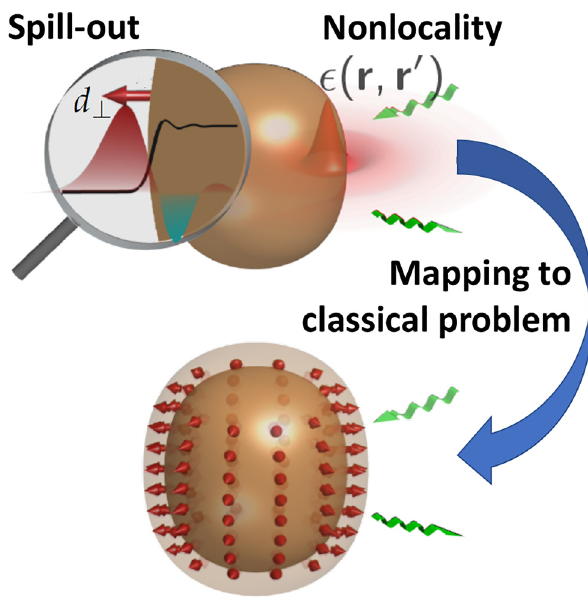
Figure 9: Light-driven quantum-plasmonic response in a metallic nanostructure (upper panel) is represented in classical electrodynamics by an infinitely thin layer of dipoles that point perpendicularly to the surface (lower panel). The metallic domain has an interior bulk part and a selvage region at the surface, constituting a transition region between the bulk and the exterior vacuum. The magnifying glass (upper panel) zooms in on the selvage, highlighting both the equilibrium electron density (black solid line), and also the microscopic distribution of the induced charge 𝜚 (red/green filled curve) which is inducing a dipole moment (red arrow) proportional to the Feibelman parameter d ⊥